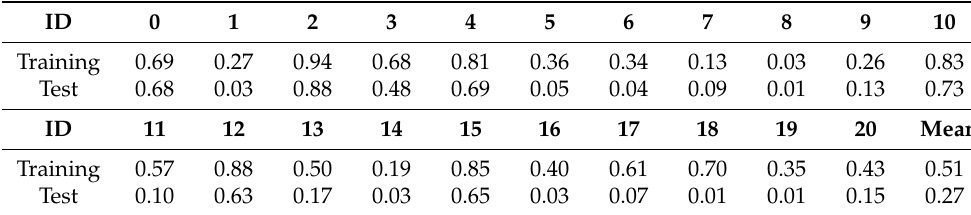
Table 12. IoU scores for Cityscapes in Experiment B.